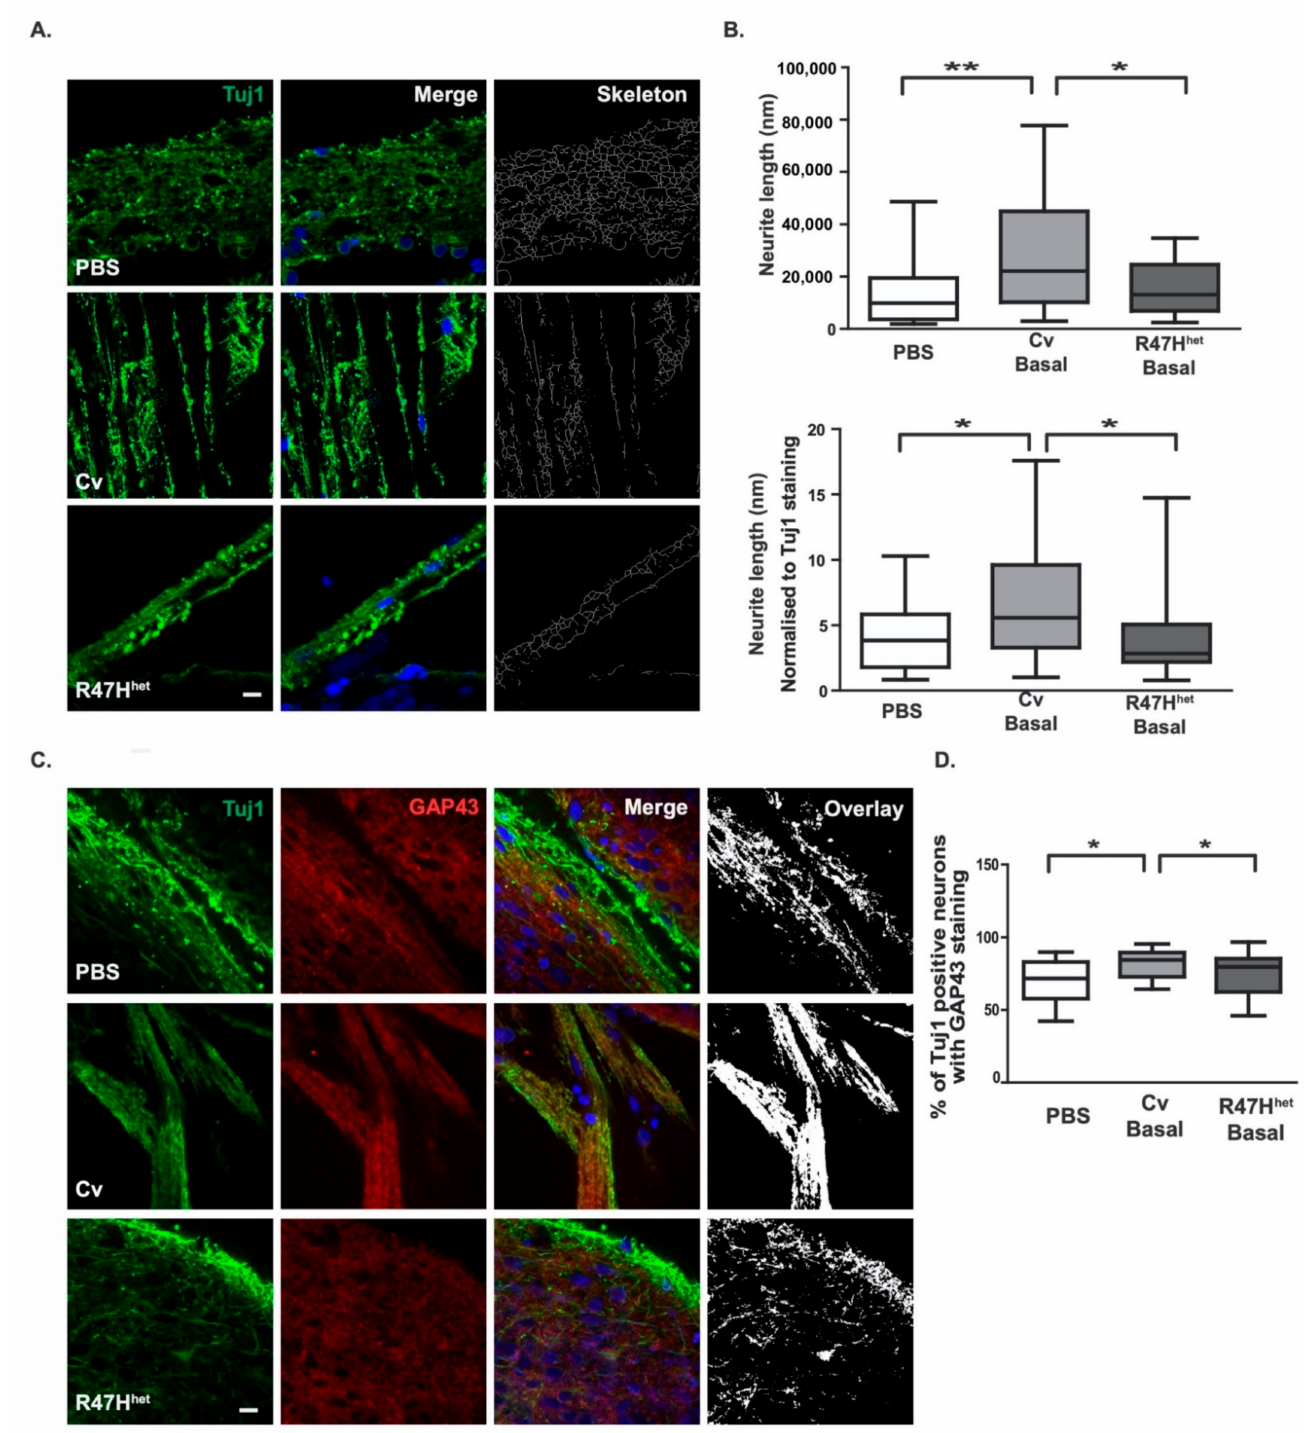
Figure 5. Microglial exosomes support neuronal outgrowth. The ability of exosomes to support neuronal outgrowth was analysed in iPS-neurons exposed to basal Cv and R47H het exosomes. Representative images of iPS-neurons stained with Tuj1 (green) and DAPI (blue nuclear stain) ( A ). Plots of skeletonised neuronal process lengths and plots of skeletonised neuronal process lengths normalised to overall Tuj1 staining ( B ) are shown. To verify whether this change was associated with increased neuronal outgrowth, the level of GAP43 staining was quantified in Tuj1-positive projections. Representative images ( C ) following quantification of the overlap ( D ) are shown. N = 3 coverslips per condition with eight ROI analysed per coverslip with one-way ANOVA. * p < 0.05, ** p <